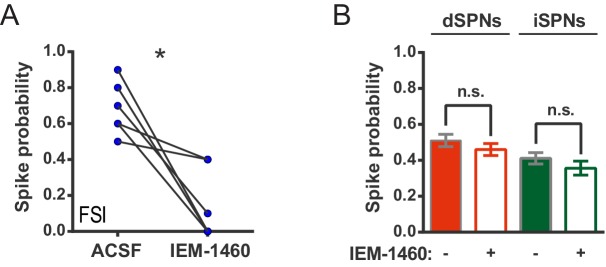
IEM-1460 inhibits evoked FSI firing but does not affect SPN spike probability.(A) Probability of evoked FSI action potential firing, as measured in cell-attached recordings, before and after wash-in of IEM-1460. Drug wash-in significantly inhibited FSI firing (t(5) = 4.08, p=0.0096, n = 6 cells). (B) Spike probability for dSPNs (red) and iSPNs (green) before (filled) and after (open) wash-in of IEM-1460 in 2PLSM calcium imaging experiments. Drug wash-in did not affect spike probability for dSPNs (p=0.055, n = 87) or iSPNs (p=0.11, n = 52). *p<0.05. Error bars represent SEM.